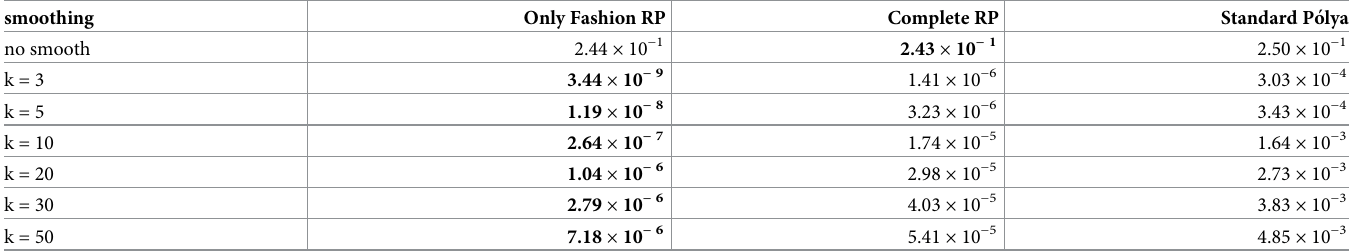
Table 7. “Migration” ( T = 0.35, entire, D = 3 0 , S = 100 slots of equal size): MSE for different levels of smoothing. smoothing